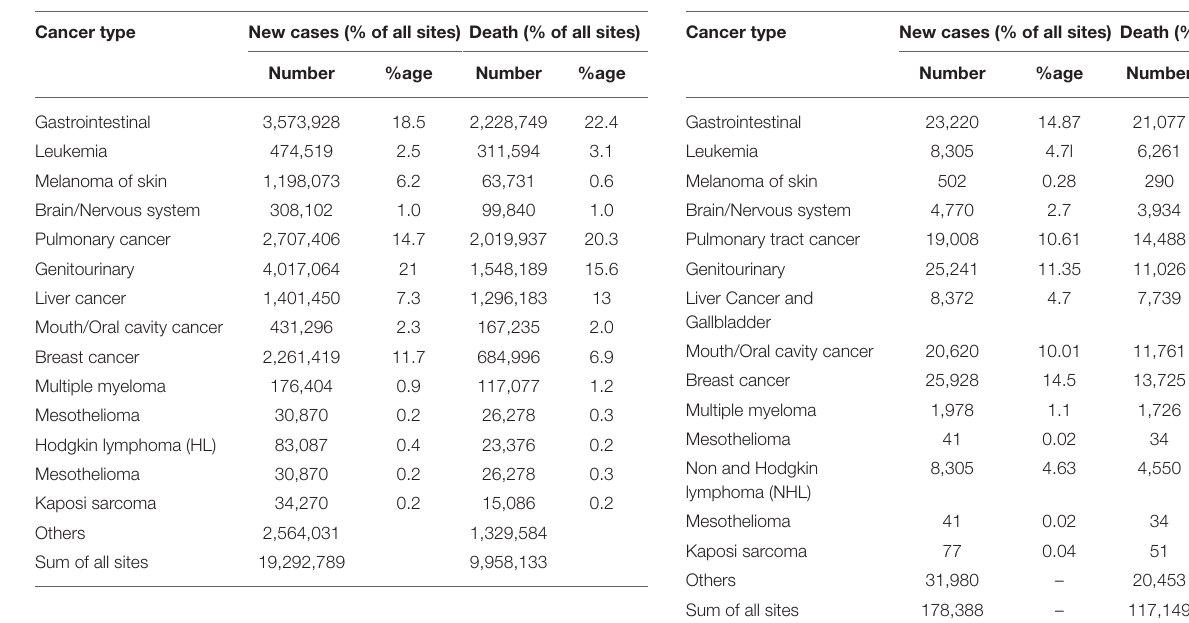
TABLE 2 | New cancer cases and death for different types of cancer in Pakistan (Data have been acquired from Global Cancer Statistics